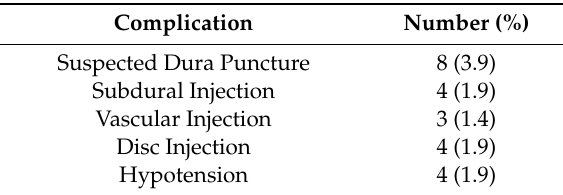
Table 3. Cumulative list and rate of the observed complications during the decompression and adhesiolysis with an inflatable balloon